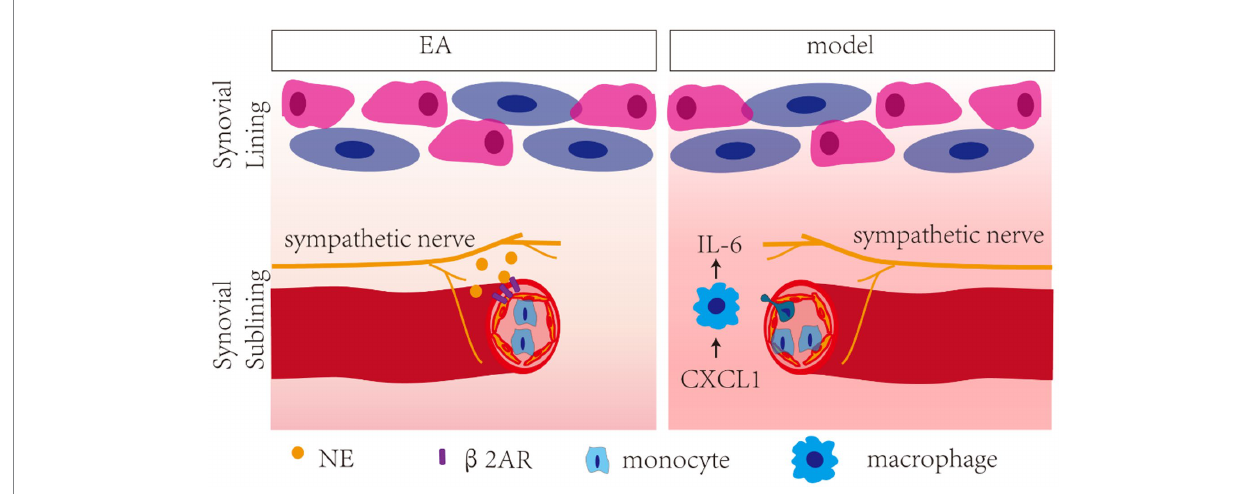
FIGURE 9 Schech map of the anti-inflammatory effect of EA in MIA-induced KOA rats. EA inhibited CXCL1/CXCR2-dependent recruitment of macrophage and its overexpression of IL-6 in the synovium by activating the β